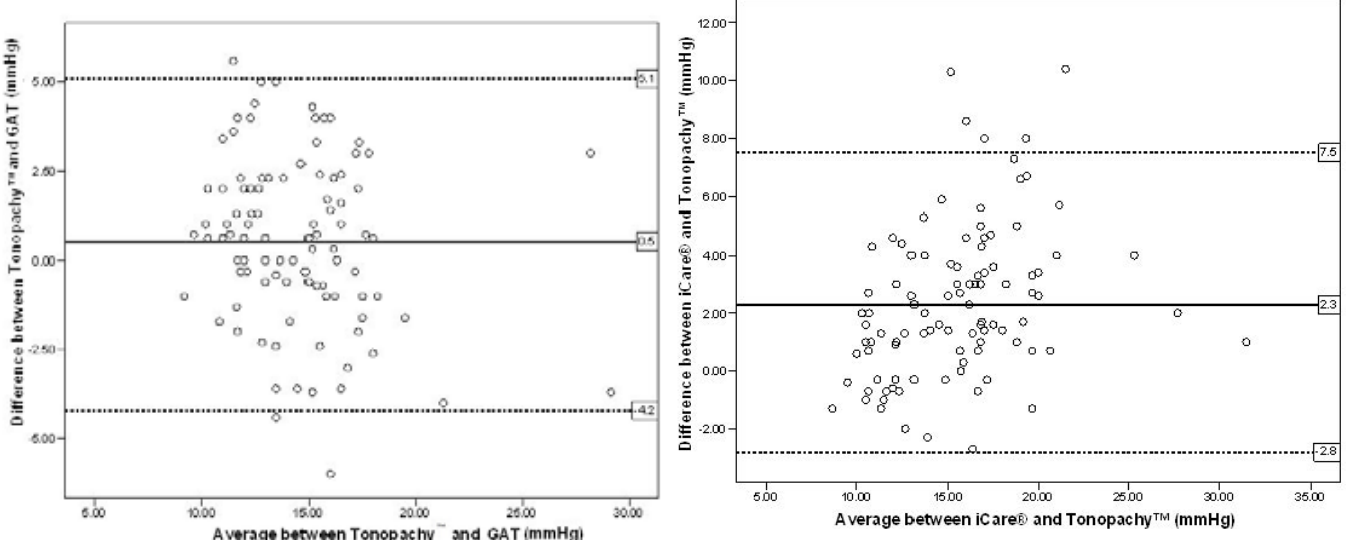
Figure 3: Bland-Altman plot of the difference between iCare ® and Tonopachy™ plotted against their means in the 105 meas- urements in the study. As in Figures 1 and 2, the solid line is the mean difference (bias) and the small dashed lines represent 95% limits of